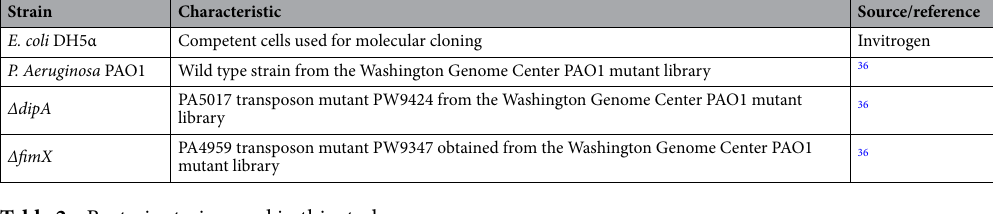
Table 2. Bacteria strains used in this